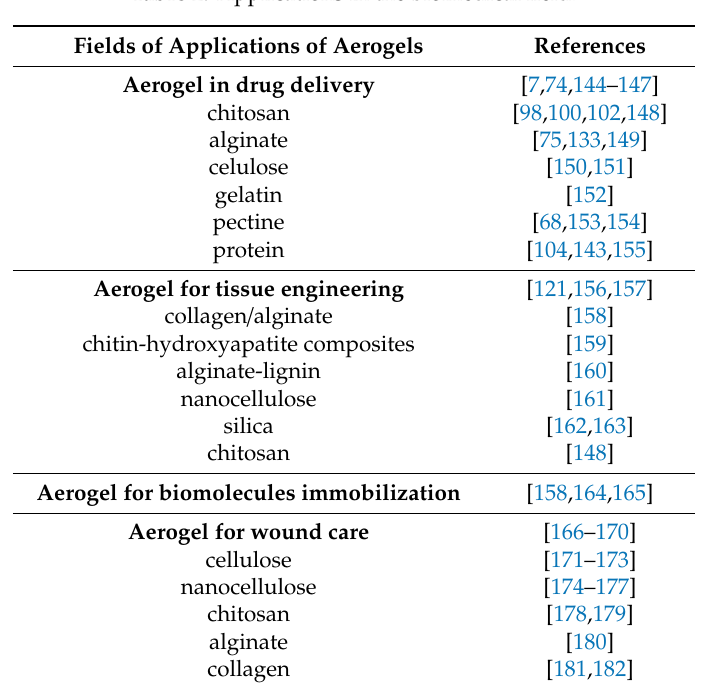
Table 2. Applications in the biomedical